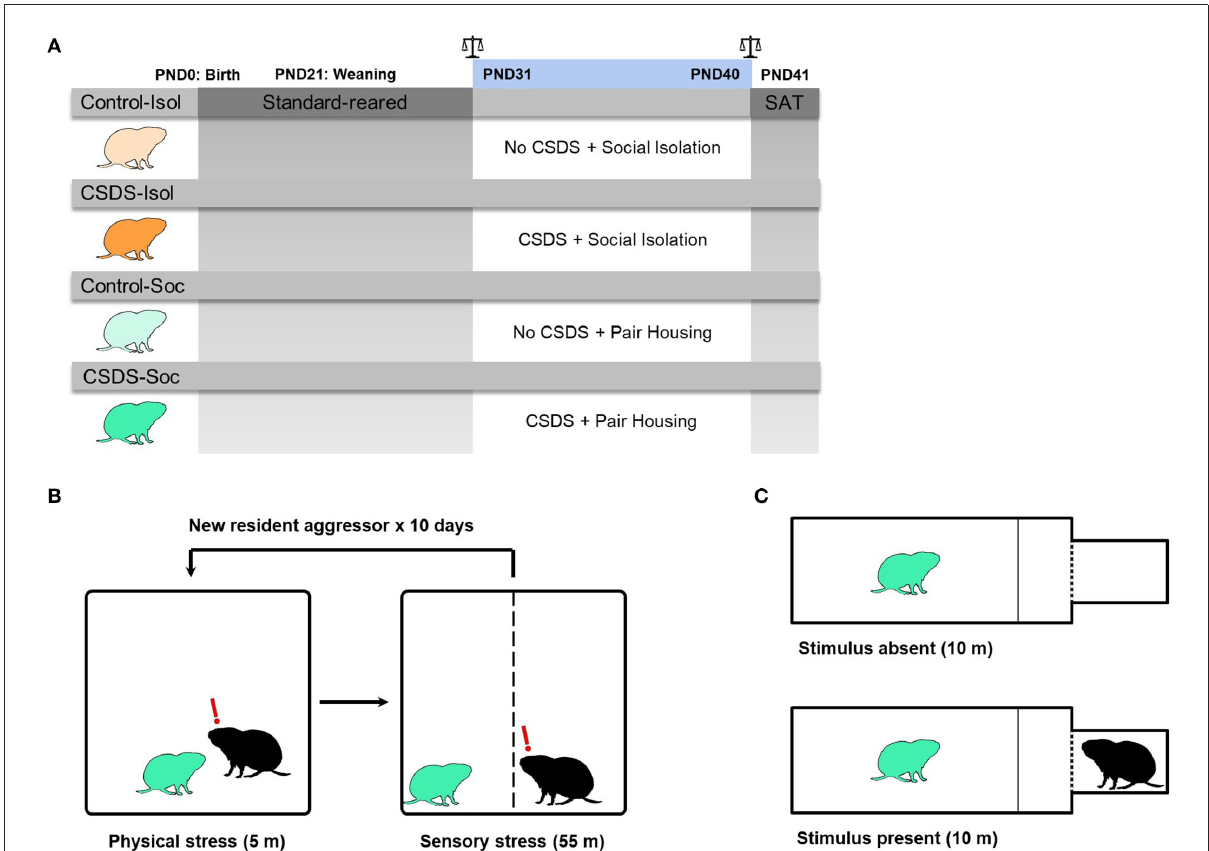
FIGURE1 Experimental design. (A) Graphical representation of the experimental timeline. Male prairie voles were standard-reared between PND0-30. In adolescence (PND31), voles from each group experienced either control conditions (Control: light orange or light green voles) or 10 days of chronic social defeat stress (CSDS: dark orange or dark green voles). After the first social defeat session, half of the voles remained in social isolation (Control + Isol and CSDS + Isol) and the other half remained pair housed with a same-sex cage-mate (Control + Soc and CSDS + Soc). Scale signs indicate that body weights of subjects and cage-mates were measured before and after CSDS, PND31 and PND40, respectively. Subjects and their cage-mates were assessed for social avoidance in the social approach test (SAT), before they were immediately sacrificed for brain tissue harvesting and gene expression analysis. (B) Diagram representing the CSDS procedure. The CSDS + Isol (dark orange) and CSDS + Soc (dark green) groups experienced CSDS, while the Control + Isol (light orange) and Control + Soc groups (light green) were placed into an empty and clean cage. (C) Diagram representing the social approach test (SAT) when the stimulus is absent (i.e., habituation phase) and when the stimulus is present ( i.e., testing phase). All groups were assessed in the SAT.